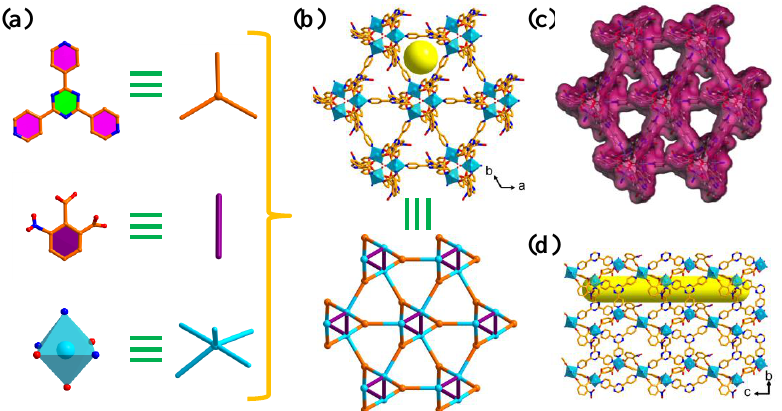
Figure 1. ( a ) Topology simplification of NiN 3 O 3 octahedron and the ligands. ( b ) The triangular channel structure and topology simplification of 3D framework in NUM-14 along the c axis. ( c ) The Connolly surface void spaces of NUM-14 . ( d ) The side view of channel structure in NUM-14 along the a-axis. Color code: Ni, sky blue; O, red; N, blue; C, light orange. Guest molecules and H atoms have been omitted for clarity.